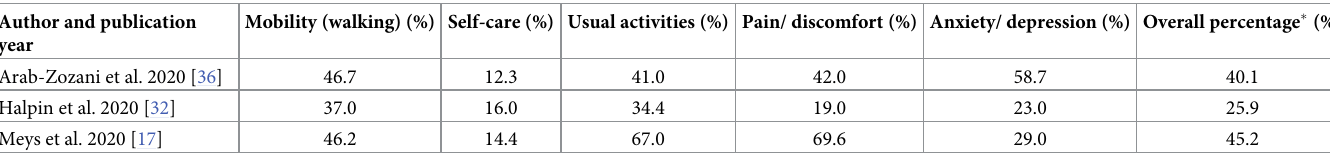
Table 4. Percentage of Long Covid patients reported problems in different dimensions of EQ-5D-5L. Author and publication